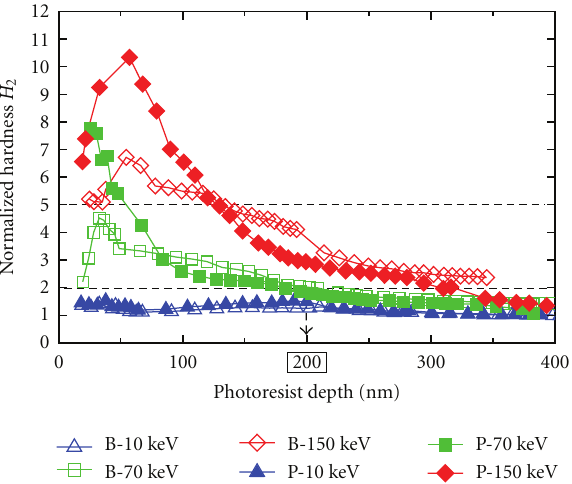
Figure 6: Depth profiles of normalized plastic-deformation hard- ness H 2 of the B and P ion-implanted resists.